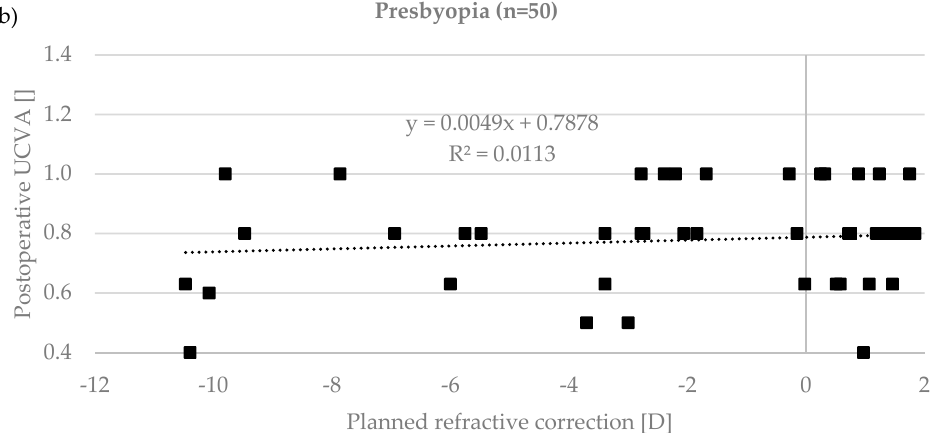
Figure 1. Trend analysis for presbyopia treatments ( b ) showed a mild correlation (R 2 = 0.01 with slope 0.005) that greater dioptric corrections resulted in lower uncorrected visual acuity (UCVA). No such correlation (R 2 = 1E-05 with slope < 0.001) between dioptric correction and resulting UCVA could be observed in the myopia ( a ) results, though.